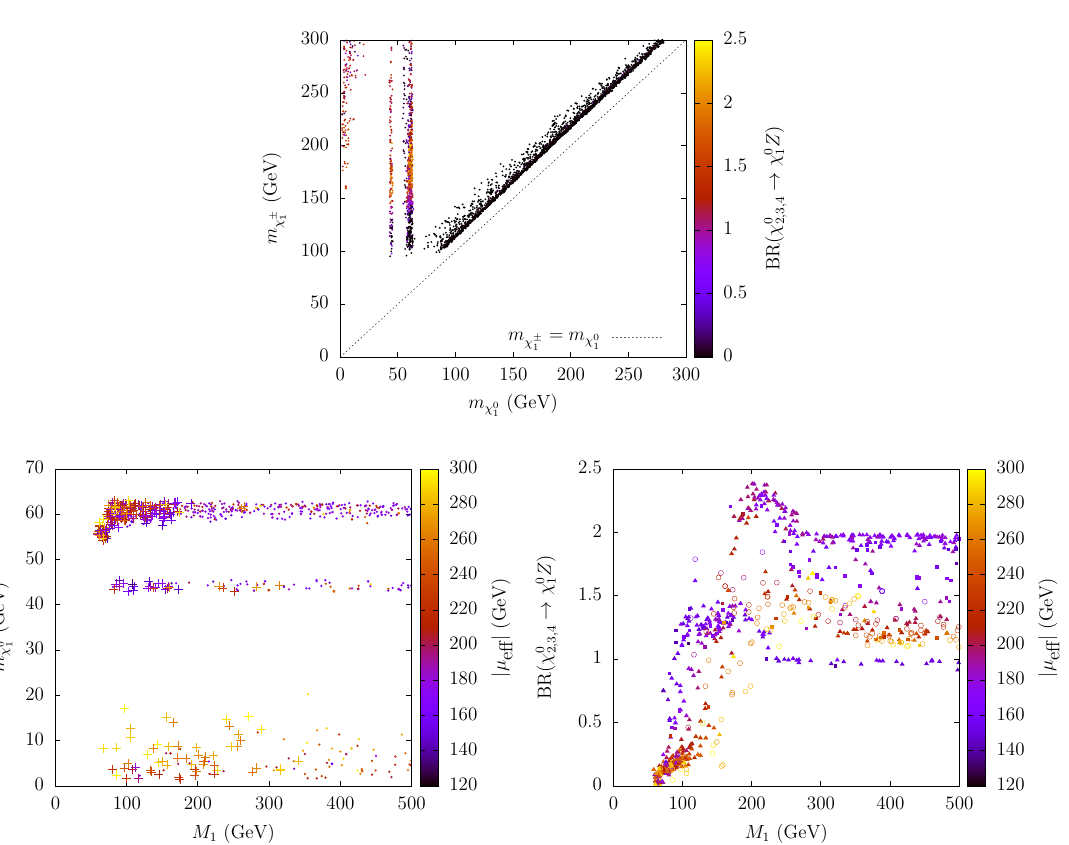
M 1 (GeV) Figure 2 . Scatter plots in various planes showing variations of relevant quantities via color-palettes for points in the Z 3 -symmetric NMSSM parameter space, with singlino-dominated LSP, obtained via scanning of the same (see text for the ranges used for various free parameters) and are consistent with all the constraints discussed in the text including those from the Higgs sector, (cid:13)avor sector, DMRD, DMDD-SI and DMDD-SD but before considering the LHC data pertaining to the ewino sector. See text for